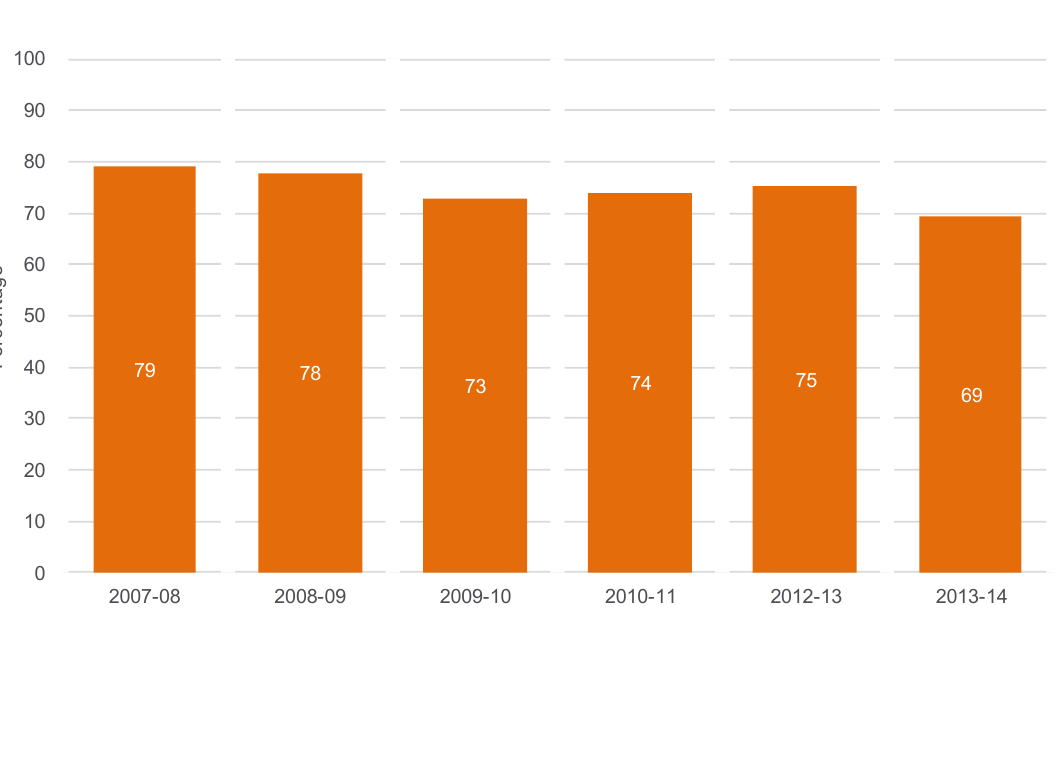
- Table 16: How important is it for you personally to feel you can influence decisions made in your local area, 2007-08 to 2013-14